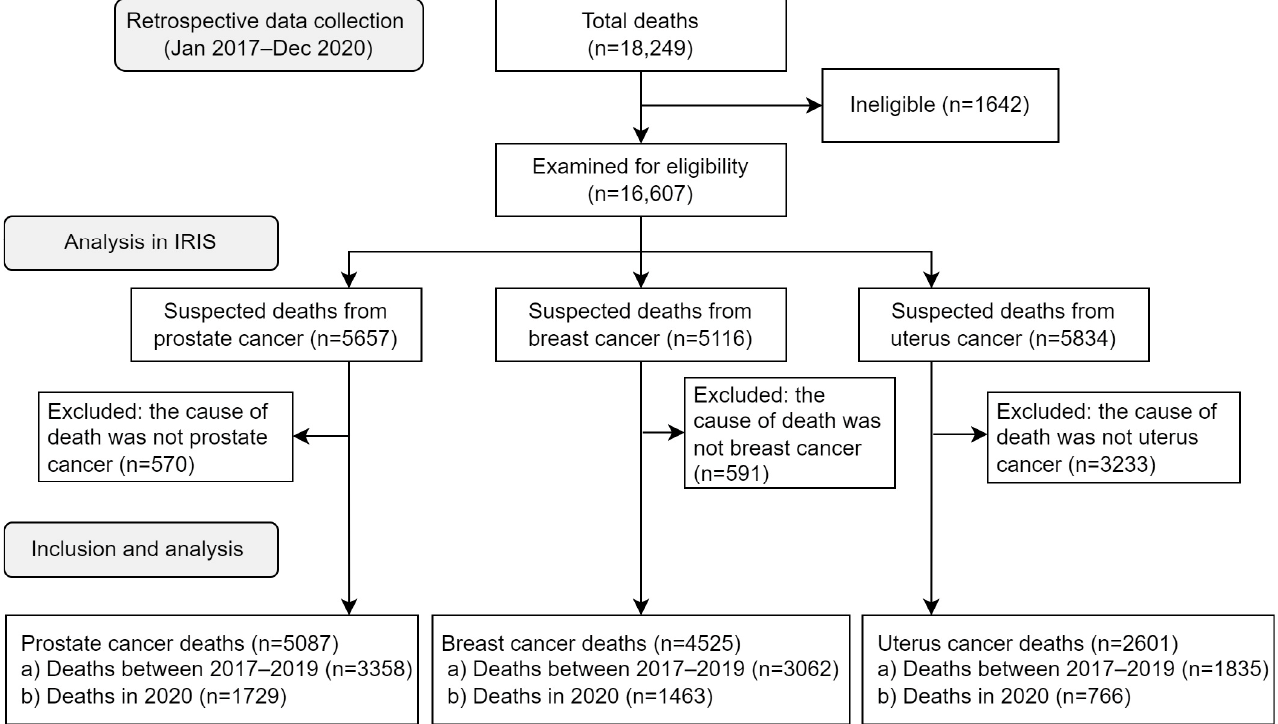
Figure 1. Study flow chart of excess cancer deaths using the STROBE reporting guidelines.